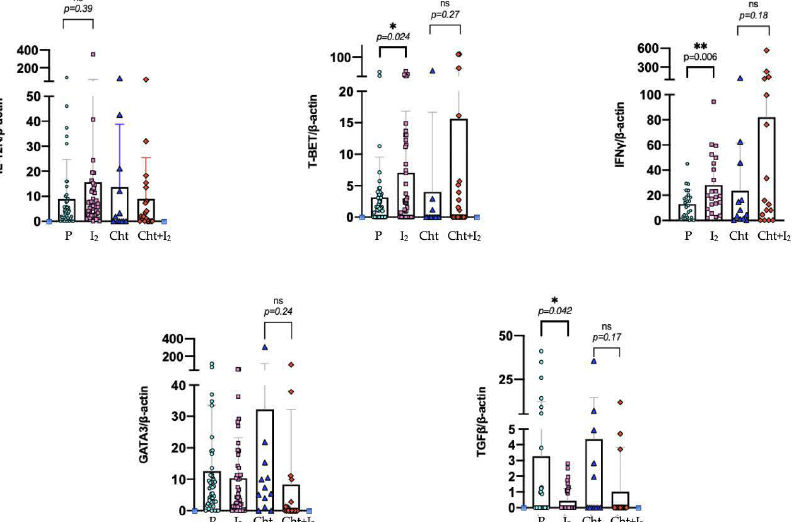
Figure 3. Gene expression of tumor suppressor cytotoxic and oncogenic inducers in individual samples. Expression was measured at the mRNA level by RT-qPCR. Data represent mean ± SD of three independent experiments from three individual samples. Significant values correspond to a Student’s t-test between I 2 and its respective control group (* p < 0.05, ** p < 0.01). P: Placebo;